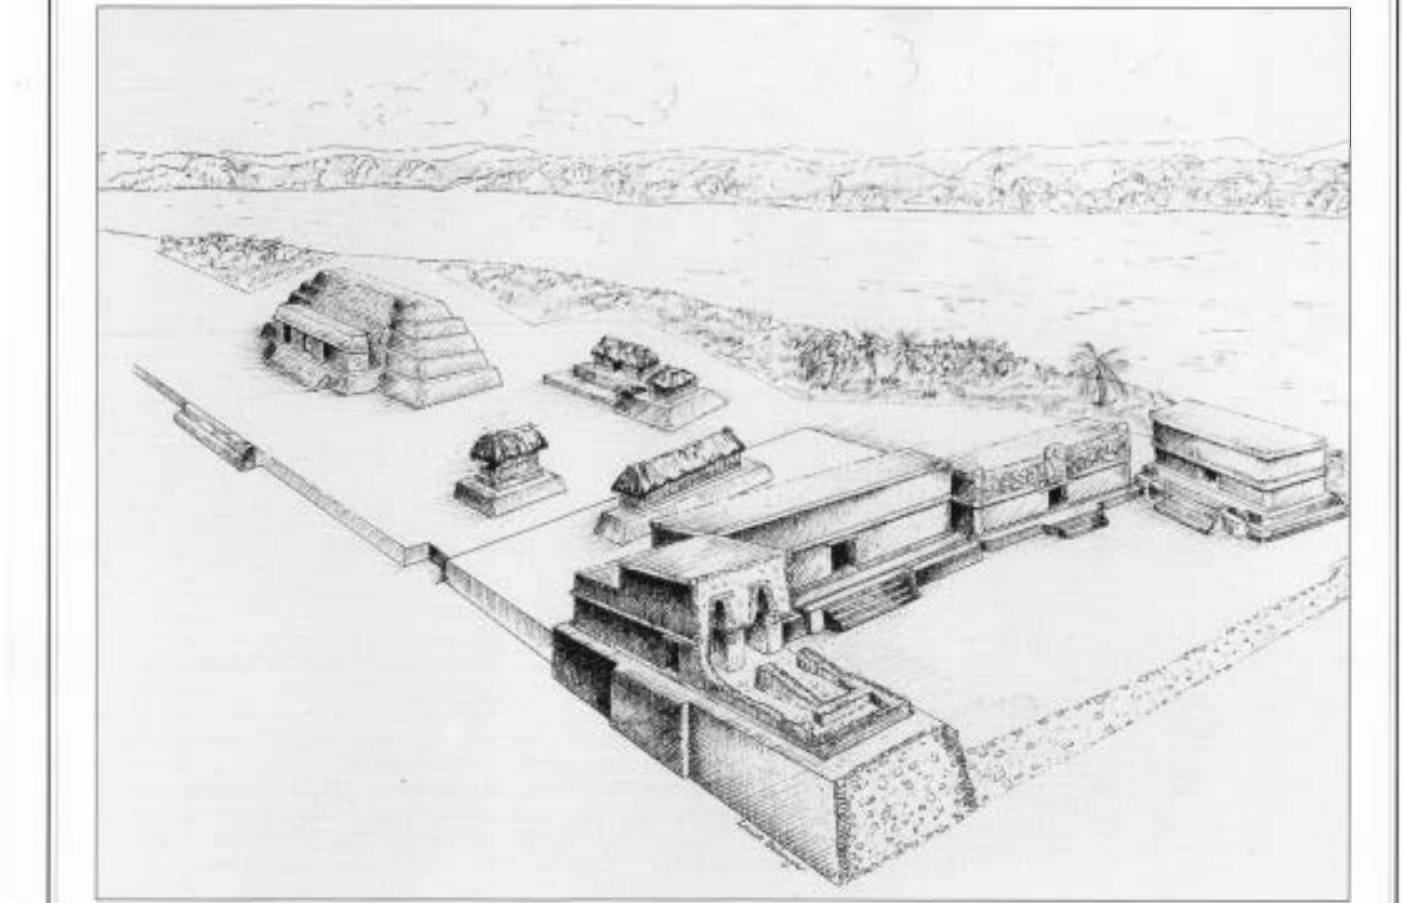
Figure 5 Reconstruction of the buildings of the Ottawa Group based on the plan shown in Figure 4; Stela 9 (see Fig. 2) can be seen in the distance in the doorway of the building (far left) known as structure N1 0-27, with the New River Lagoon in the background. periods of transition that are so little known at other